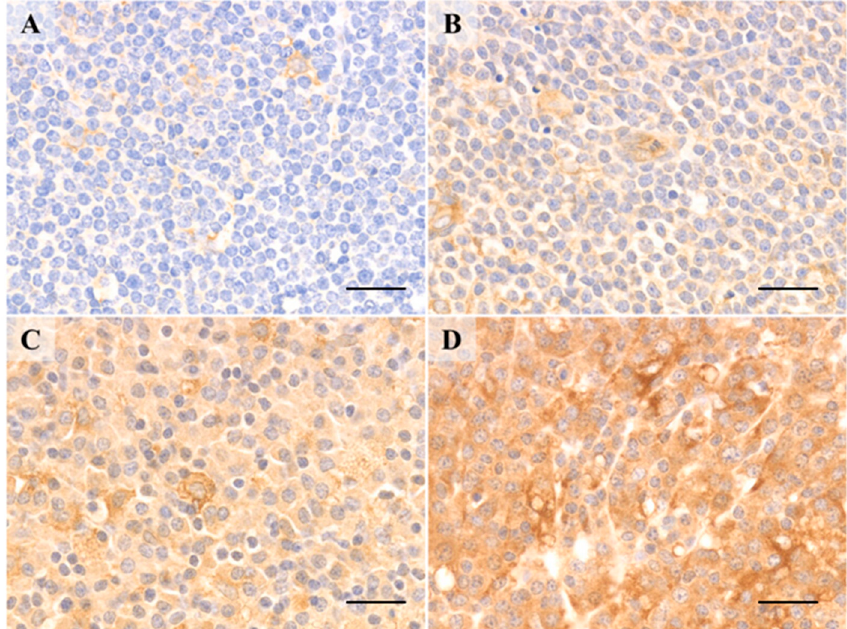
Figure 4. Activation-induced cytidine deaminase intensity index with immunohistochemical staining. Representative images of ( A ) Negative (0), ( B ) weakly positive (1), ( C ) moderately positive (2), and ( D ) strongly positive (3) activation-induced cytidine deaminase intensity index with immunohistochemical staining. Samples from patients with IgG4-related ophthalmic disease and IgG4-positive marginal zone lymphoma had strongly positive lymphoid and plasmacytoid cells with AID in both germinal centers and interfollicular regions (AID immunostaining, Scale bar; 50 µm).